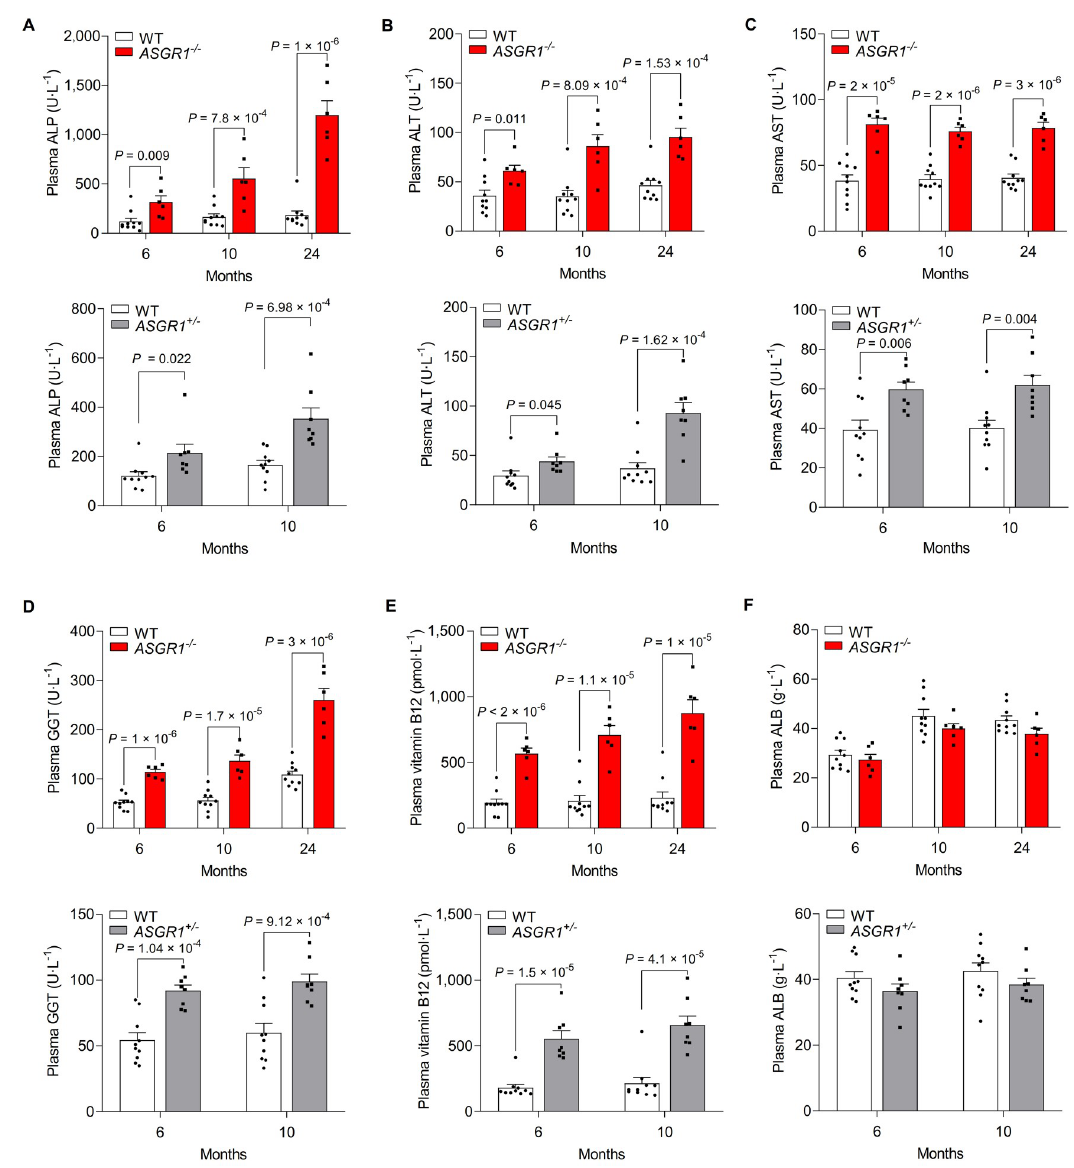
from individual pigs, at the indicated time points ( n = 6 for ASGR1 -/- pigs, n = 8 for ASGR1 +/- pigs, n = 10 for WT pigs, data represent two independent experiments combined). P values are shown for indicated comparisons by the Student’s t -test. Values are mean ± SEM. The underlying data for this figure can be found in S1 Data . ALB, albumin; ALP, alkaline phosphatase; ALT, alanine aminotransferase; AST, aminotransferase; GGT, gamma glutamyl transpeptidase; WT,